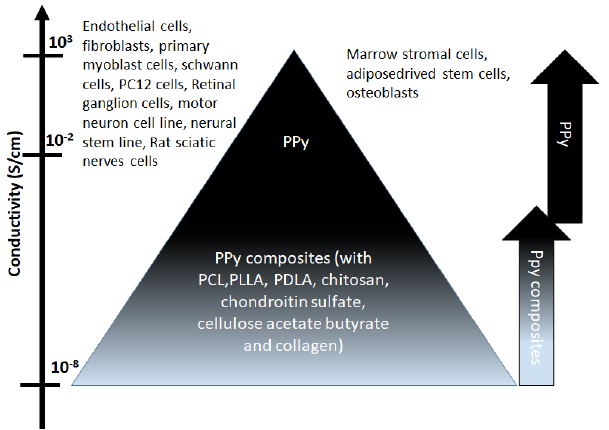
Figure 3. Cells and PPy or its composite served as electrodes and substrates used for electrical stimulation. PPy sheets or PPy membranes synthesized by electrochemical/chemical methods present higher conductivity compared to the PPy composites. (PCL: polycaprolactone, PLLA: poly-L-lactide, PDLA: poly-D-L-lactide).